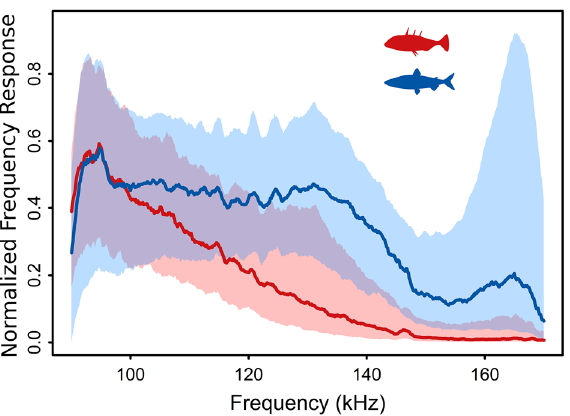
Figure 4. Comparison of the relative frequency response curves (FRCs) for stickleback (red) and whitefish (blue). The bold line is the median and the shaded polygon region includes the 25–75 percentile observations from all individuals of both species, and overlapping regions are shown by combined colours.